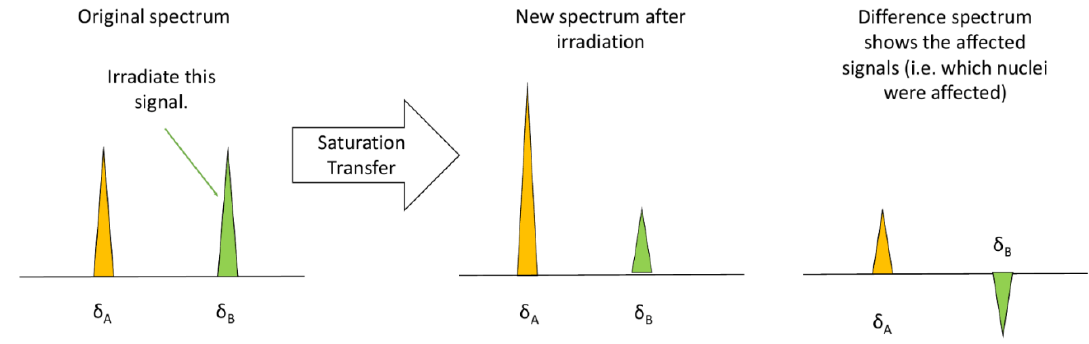
ff erent NOE e ff ect on NMR Figure 8. Basic layout of the different NOE effect on NMR signals. Figure 8. Basic layout of the di